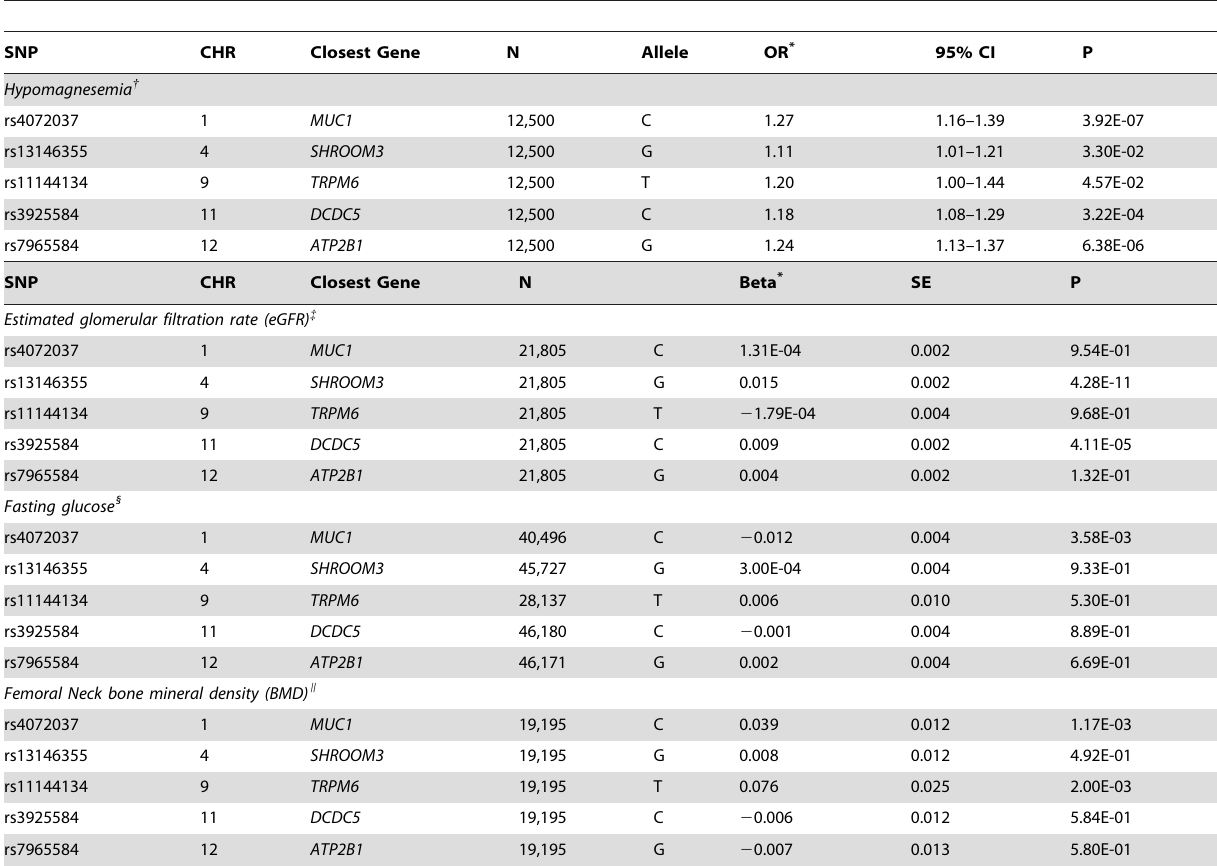
Table 3. Association between hypomagnesemia, estimated glomerular filtration rate, fasting glucose, and bone mineral density with the lead replicated SNPs showing genome-wide significant associations with serum magnesium concentrations.